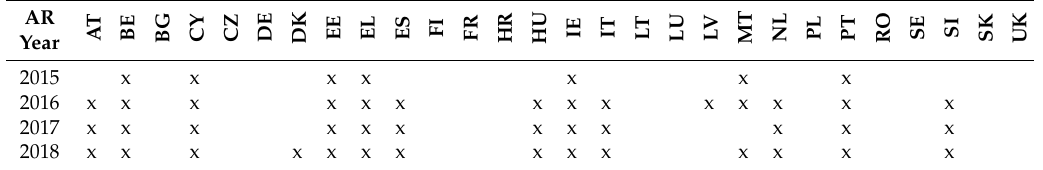
Table 1. Usage of the AR common reporting template introduced in